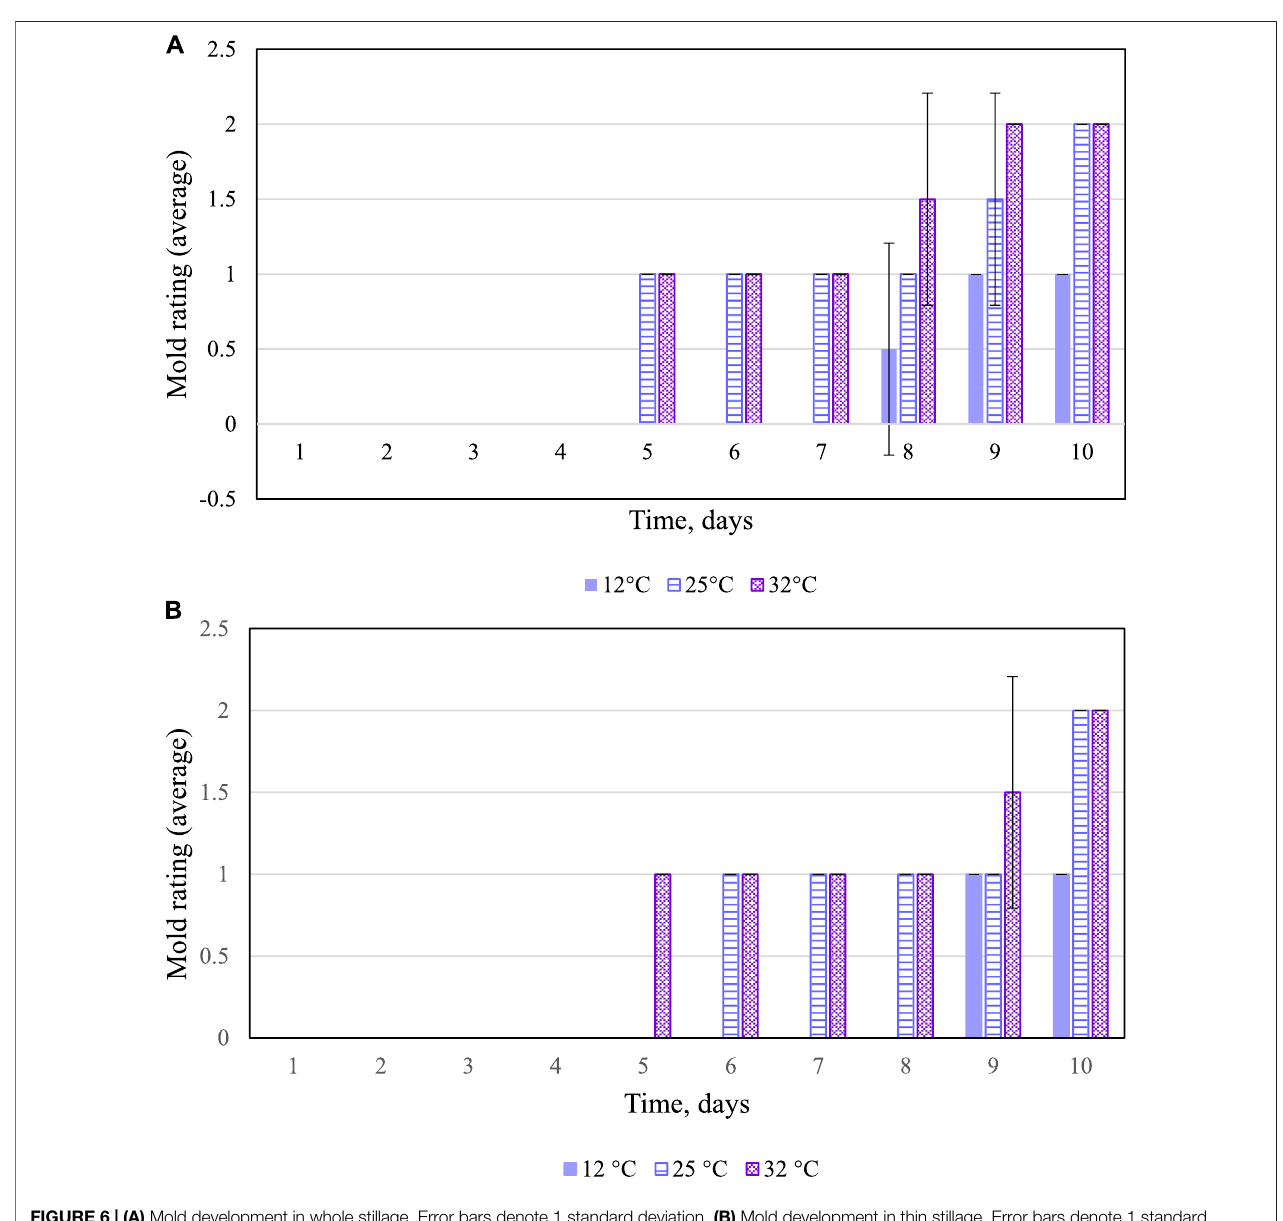
FIGURE 6 | (A) Mold development in whole stillage. Error bars denote 1 standard deviation. (B) Mold development in thin stillage. Error bars denote 1 standard